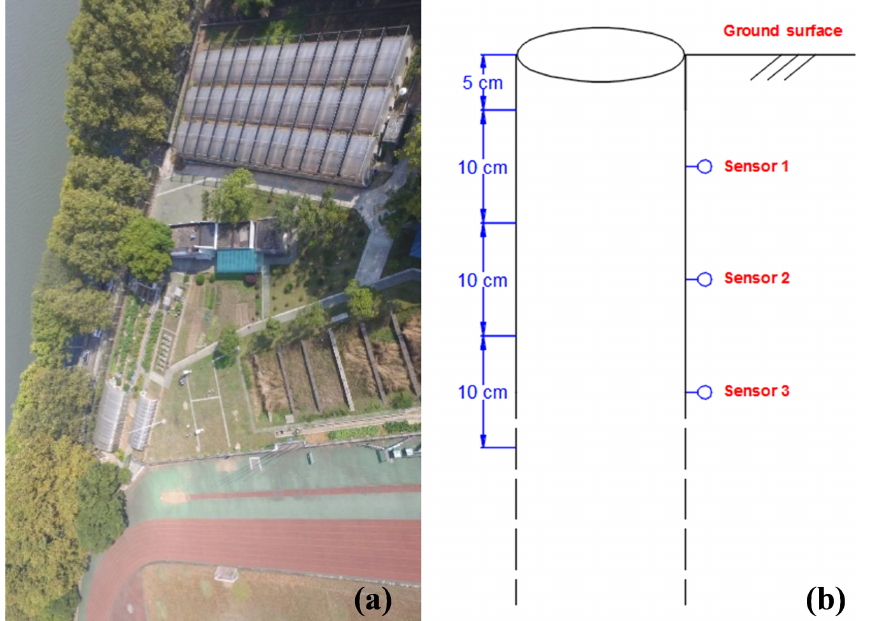
Figure 10. The experimental site: (a) overhead view and (b) the cross-sectional view of the FDR sensor.